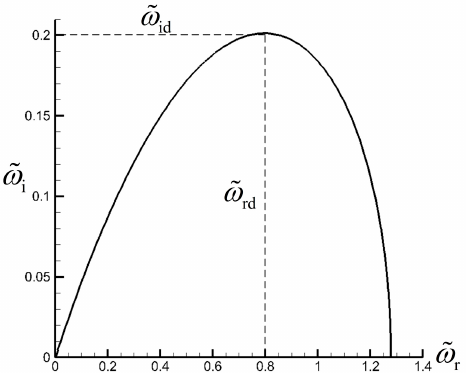
Figure 7. Growth rate of different frequencies in free shear flow by linear stability theory.